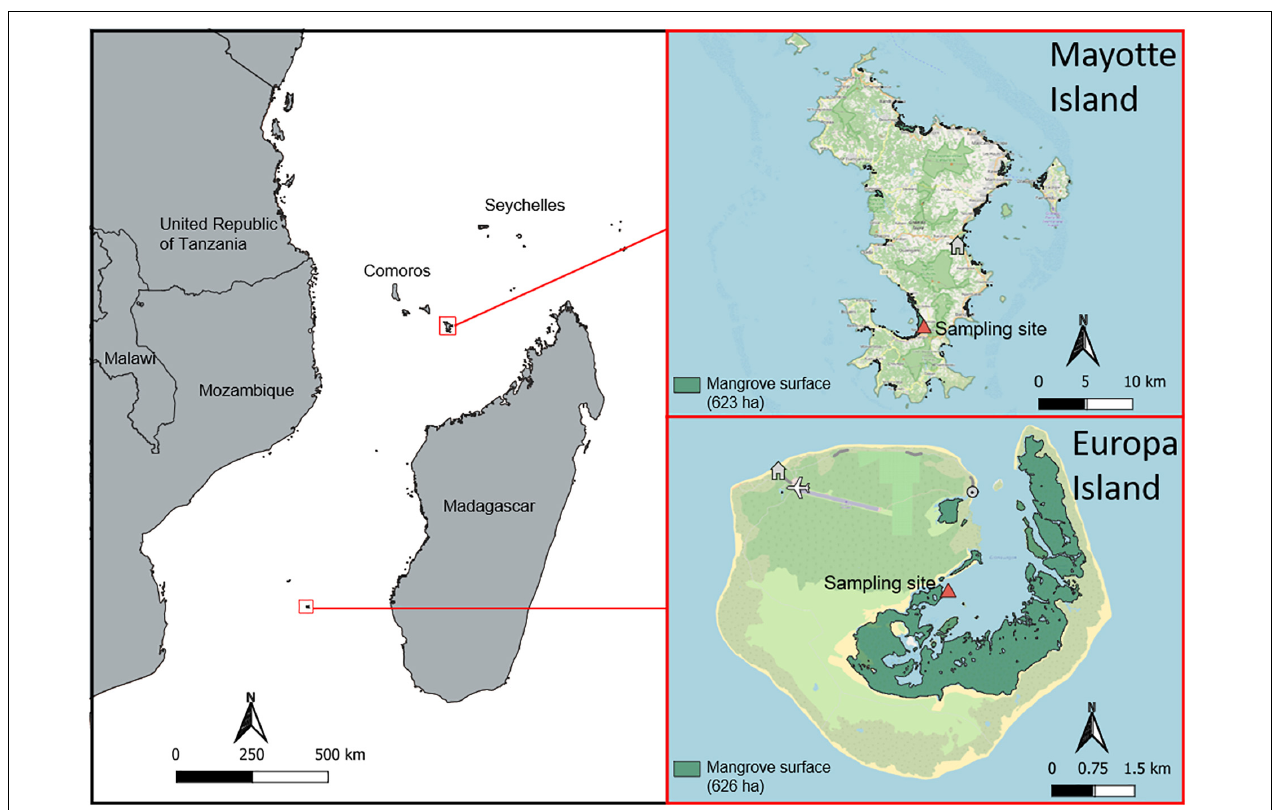
FIGURE 2 | Localization of Mayotte Island and Europa Island in the Mozambique Channel with the sampling sites.